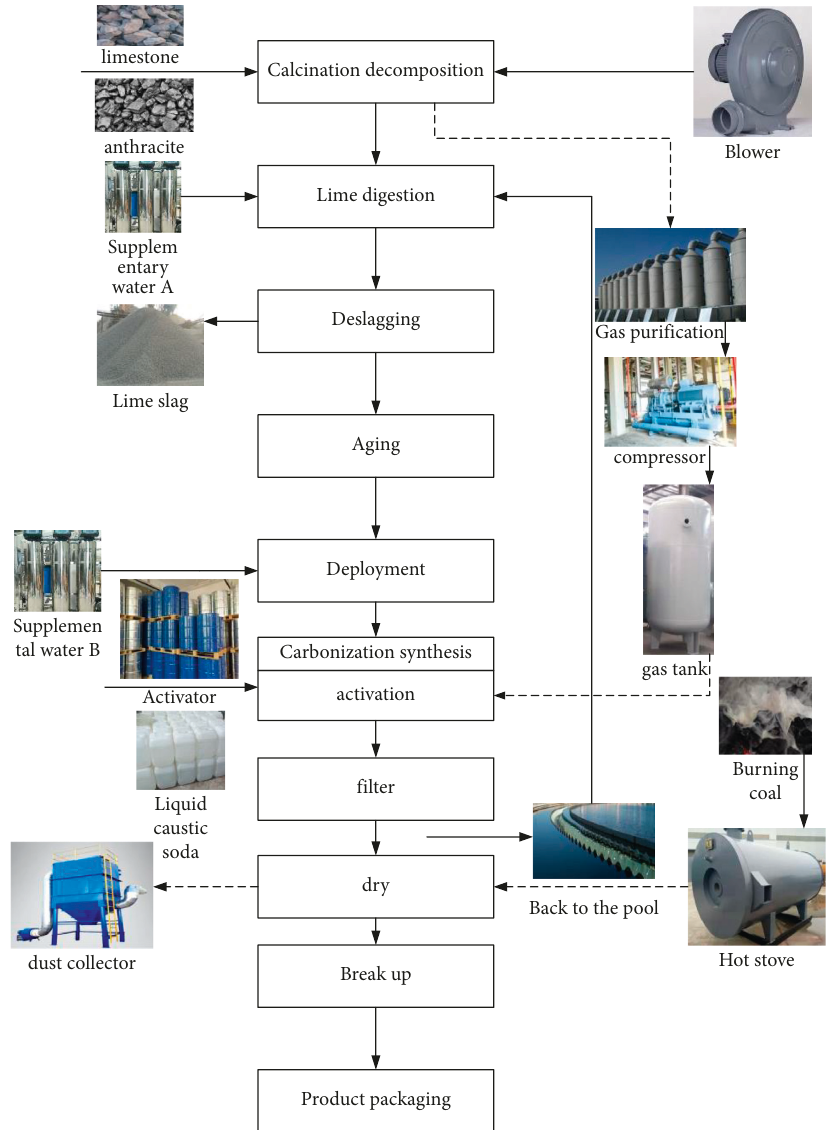
Figure 1: Preparation process of nano-calcium